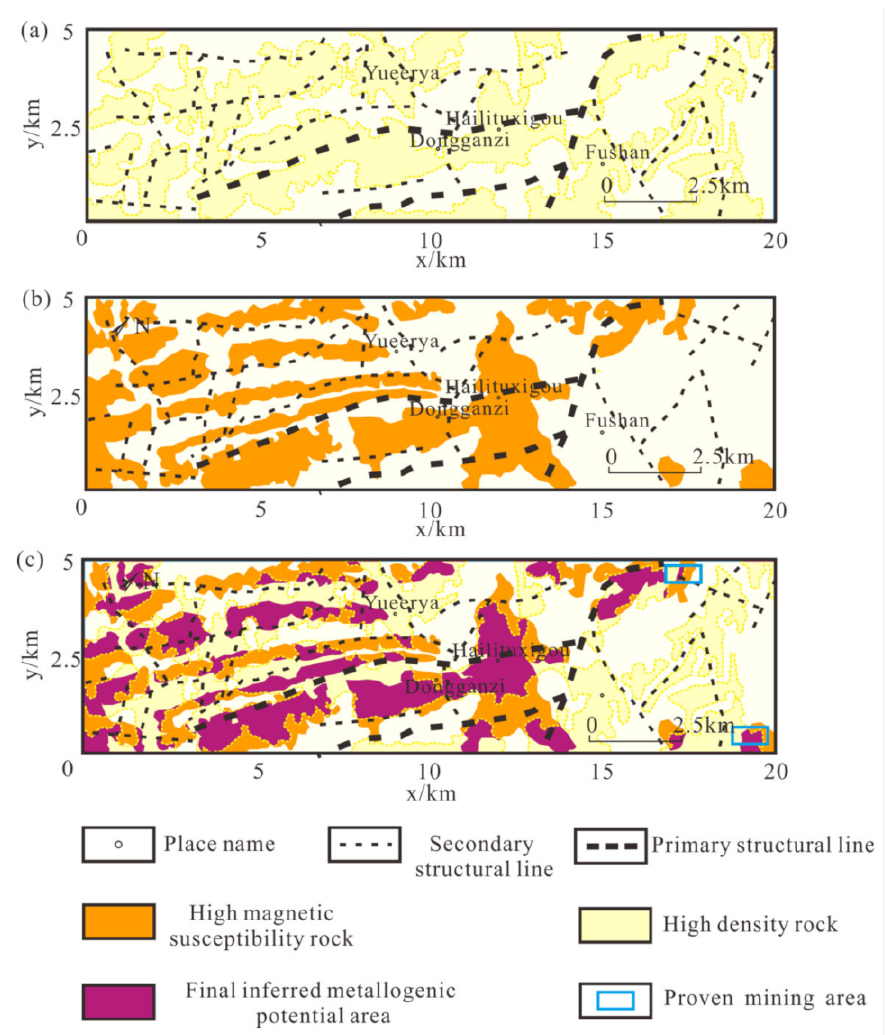
Figure 12. Delineation of metallogenic potential area: ( a ) High density rocks delineated by gravity anomalies; ( b ) High magnetic susceptibility rocks delineated by magnetic anomalies; ( c ) Final inferred metallogenic potential